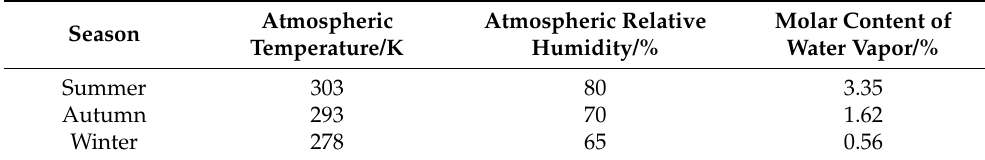
Table 7. Typical atmospheric conditions in different seasons.